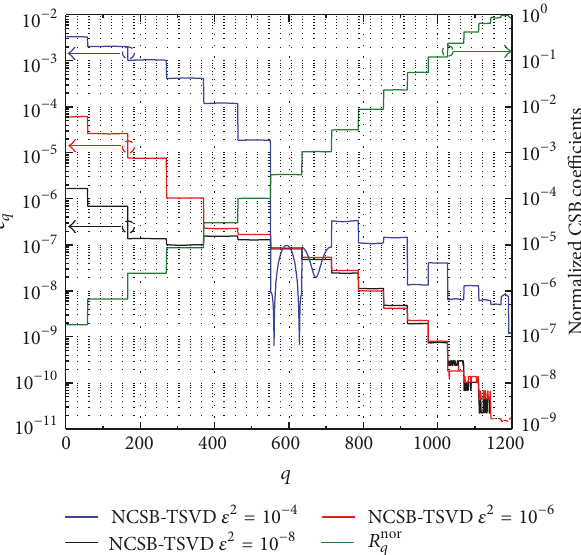
Figure 4: Relative translation